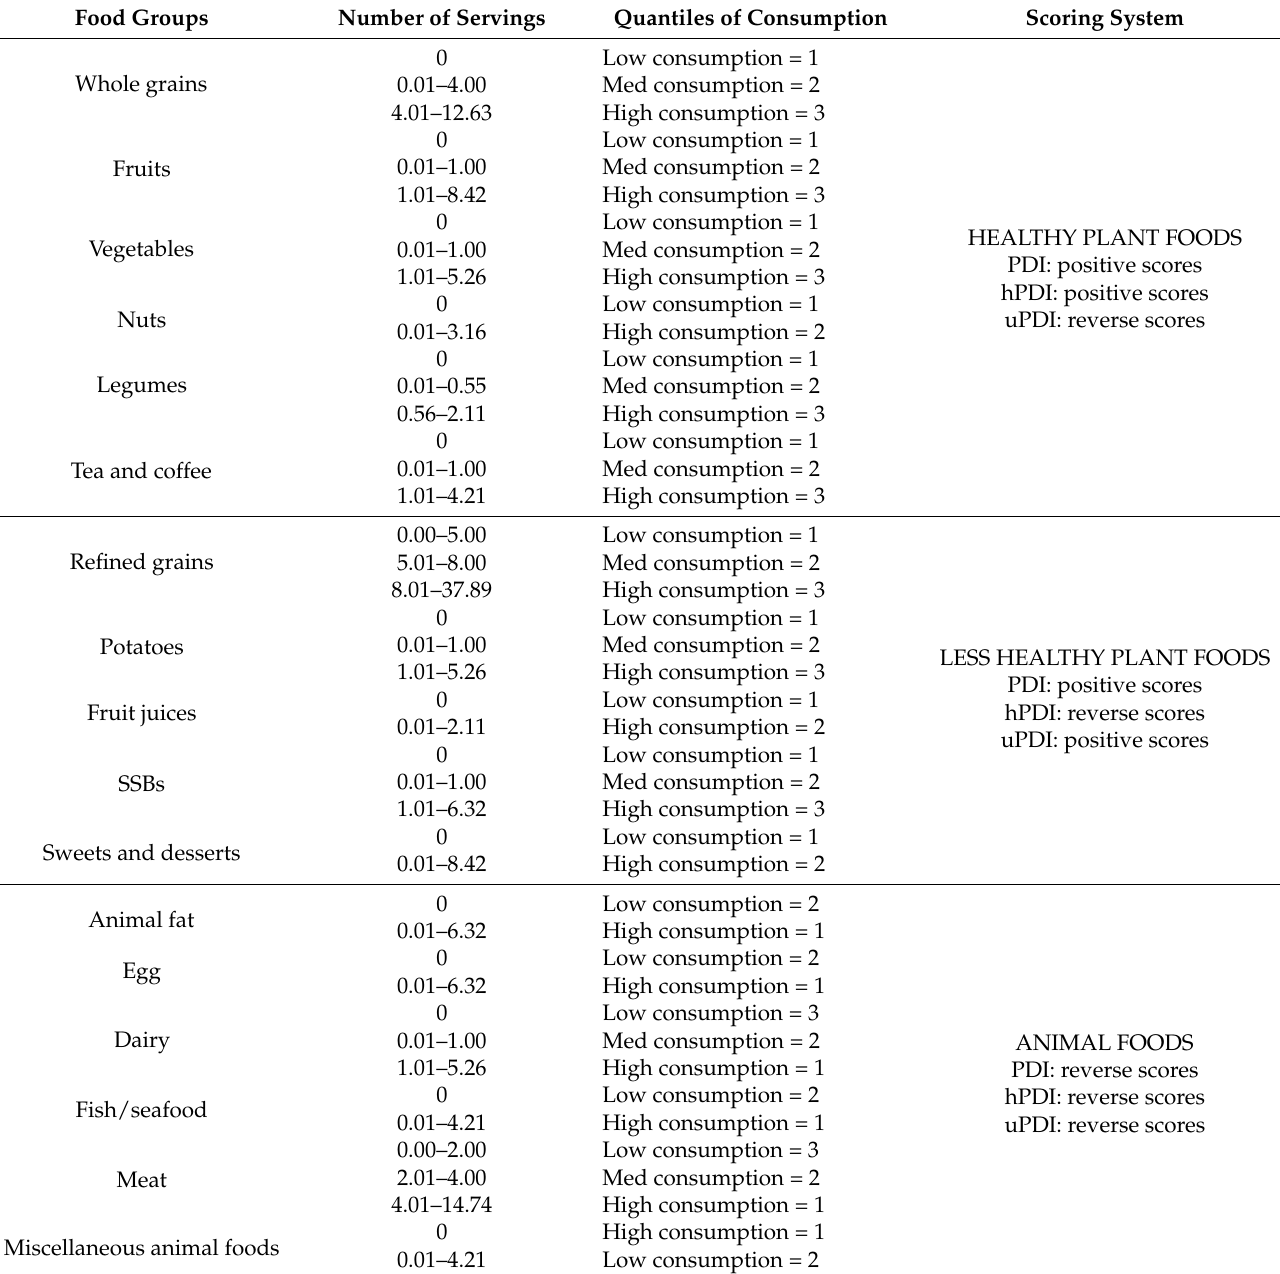
Table 1. Scoring of the food groups used to calculate the PBD